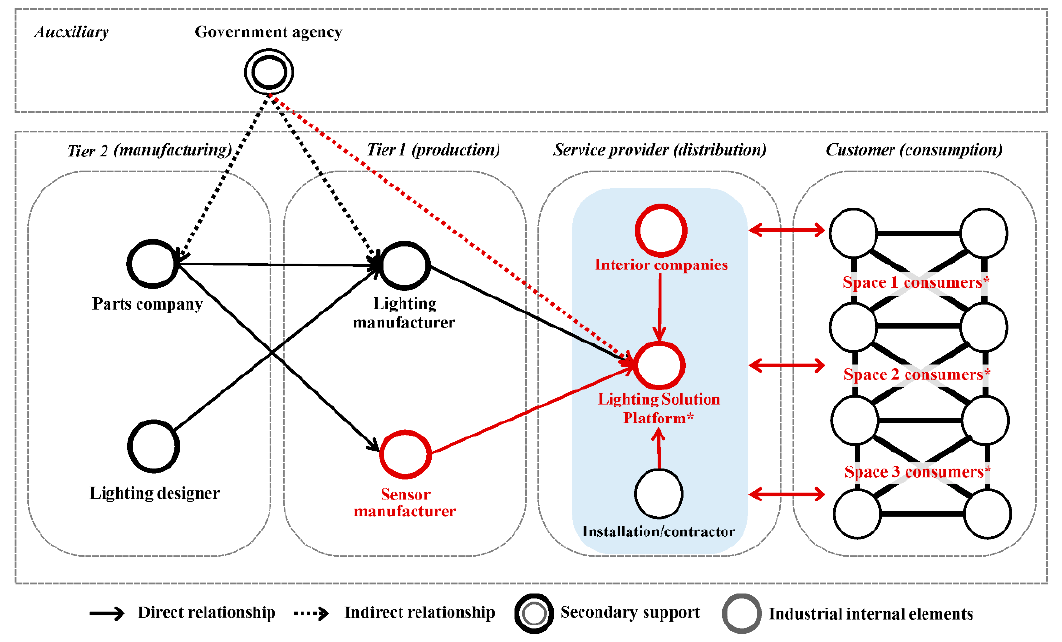
Figure 5. HCL TO-BE